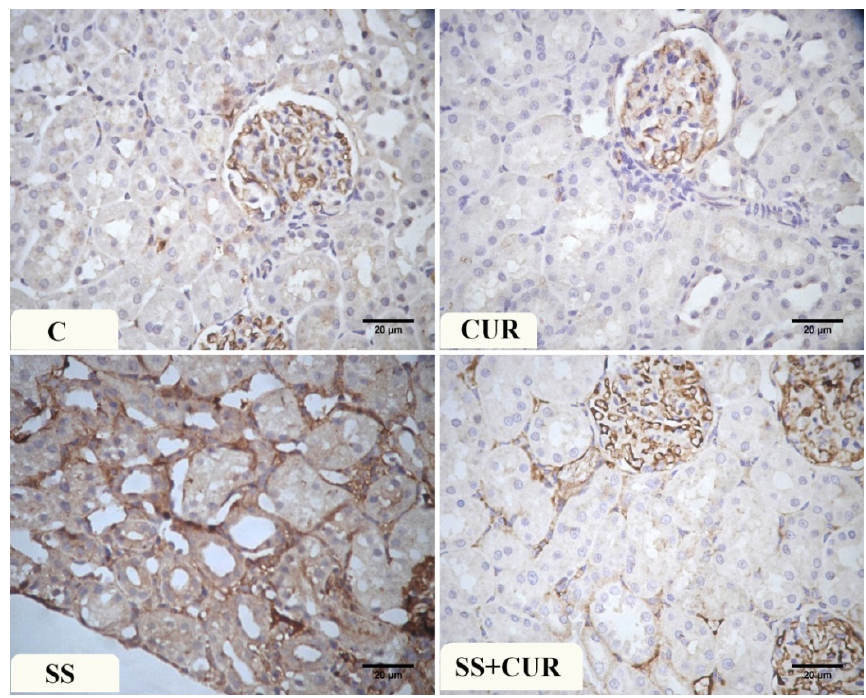
Figure 4. Photomicrograph of the renal tissue sections showing the Caspase -3 immuno-expression in different studied groups: (C) control, (CUR) curcumin, (SS) sodium salicylate, and SS+CUR-treated groups. Magnification ×400.